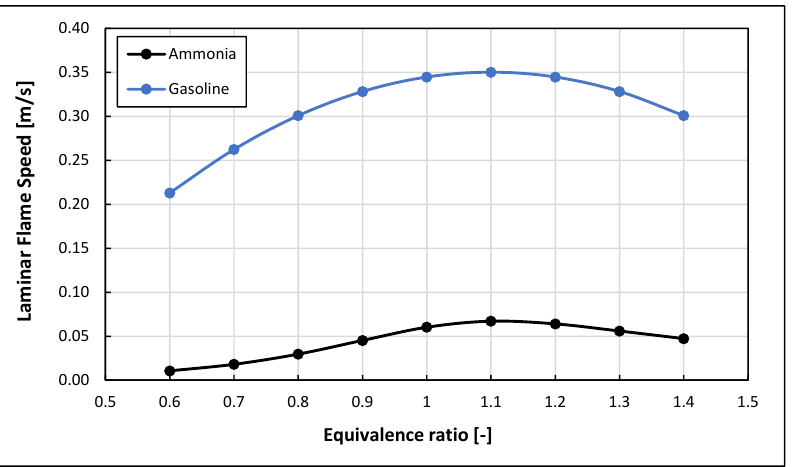
Figure 2. Laminar flame speed under ambient conditions calculated for gasoline–air mixtures and ammonia–air mixtures.